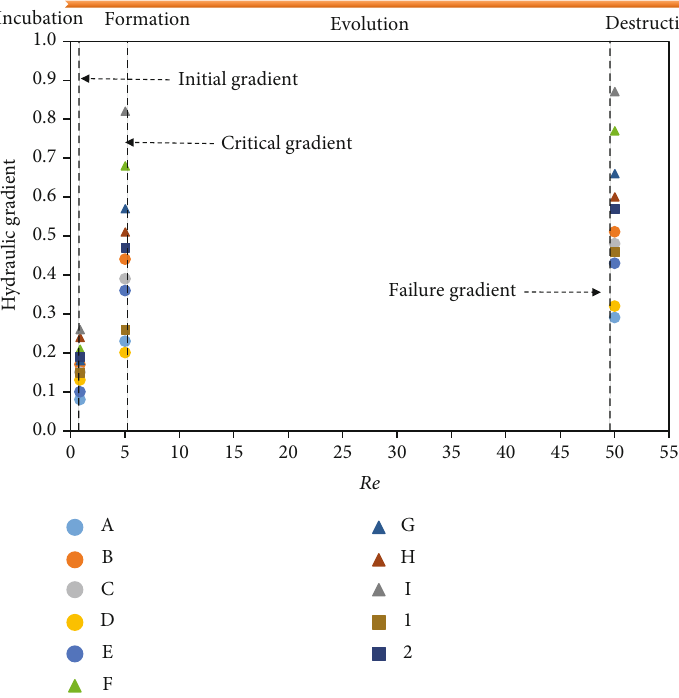
Figure 19: Various samples of failure process division with the Reynolds number and hydraulic